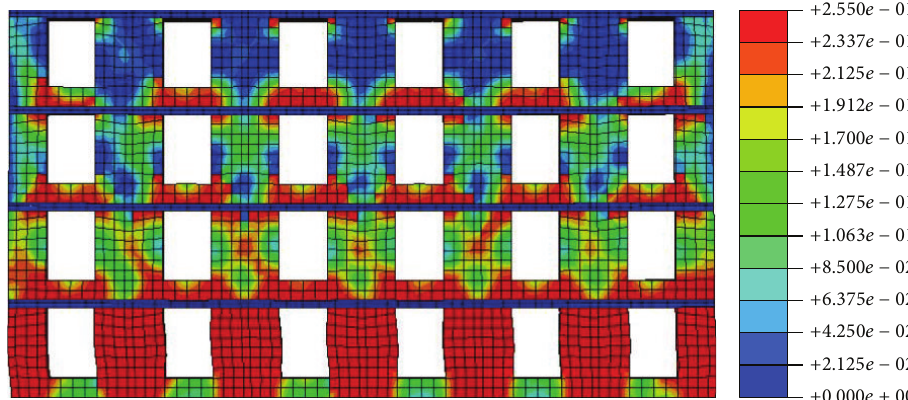
Figure 20: Tension crack damage cloud of model 6 under Wolong ground motion.